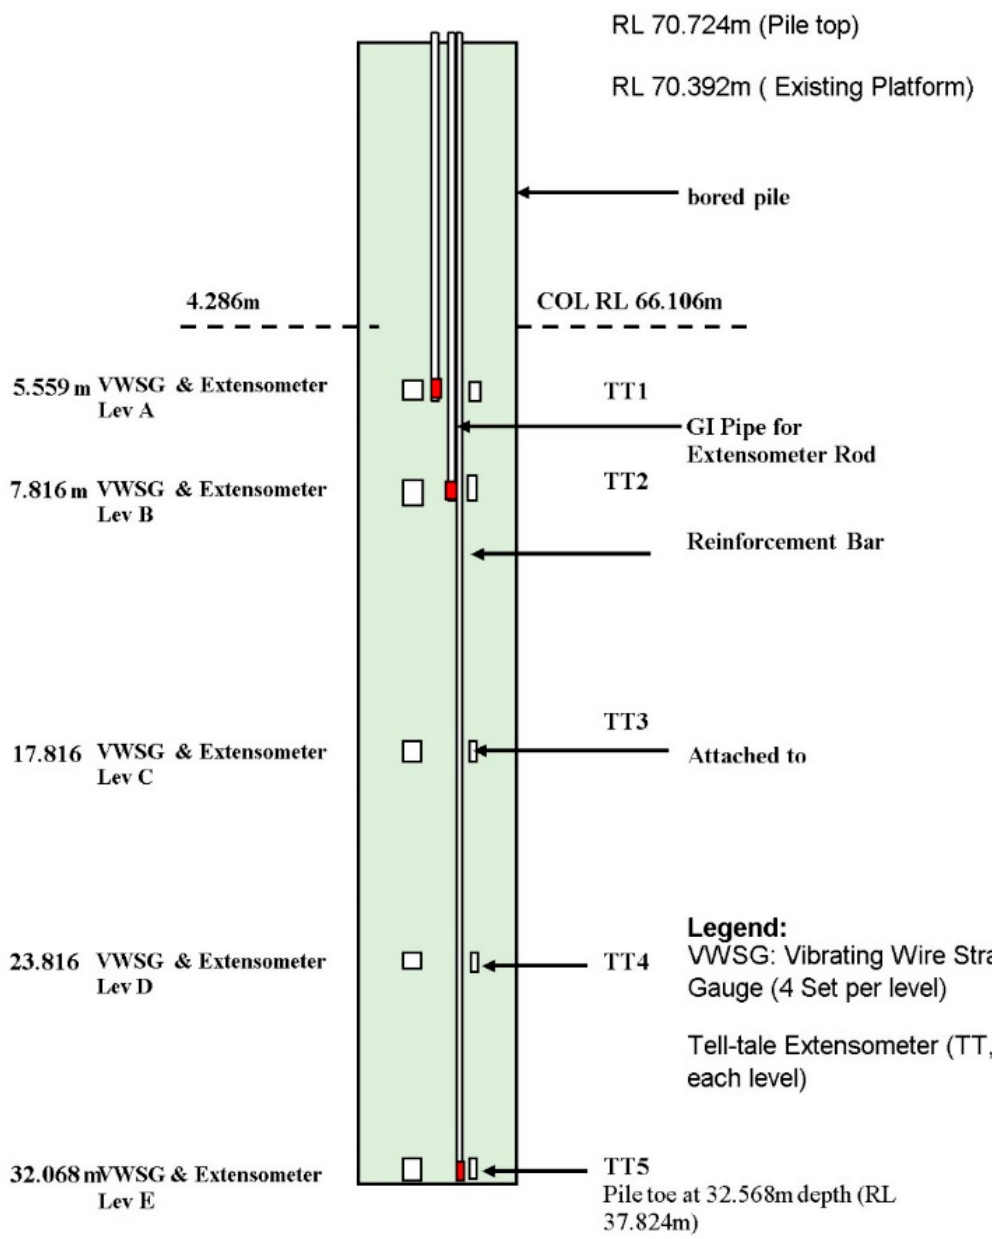
Figure 6. Vibrating wire strain gauges and tell-tales’ extensometer arrangement in BP# 2.